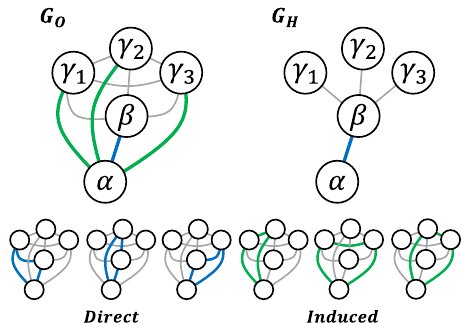
Fig. 3 A schematic illustrating the number of triangles formed in a single time step of the correlated copying model. G O : the observed network, G H : the hidden network. The new node, α , forms a direct edge (blue) to a node β which has three existing hidden neighbours ( γ 1 , γ 2 , γ 3 ). The copying process forms three new edges (green) in G O . The copying process results in three new direct triangles (outlined in blue), involving the edge { α , β }, and three new induced triangles (outlined in green), excluding the edge { α , β }. Triangles are formed in the observed network only; the hidden network remains a random tree. Note that in G O and G H , the grey edges represent the existing network, while in the small graphs at the bottom they represent edges that are not part of the outlined Clustering . Transitivity is a global clustering measure de fi ned as # ð triangles in G Þ τ ¼ 3 ´ ð 31 Þ O # ð twigs in G G O where a twig is any three nodes connected by two edges. The number of twigs is equivalent to the number of star graphs of size 2, S 2 , where a star graph of size n is a subgraph with 1 central node and n connected neighbours. The number of subgraphs of size 2 is related to the degree distribution by